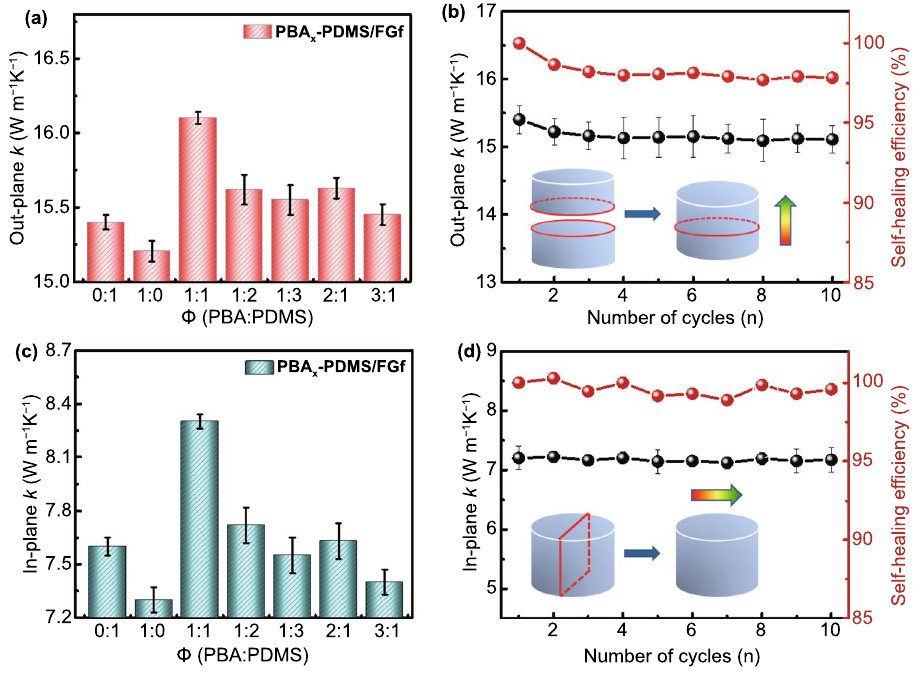
Fig. 4 a Out-plane thermal conductivity and b self-healing efficiency of PBA–PDMS/FGf. c In-plane thermal conductivity and d self-healing efficiency of